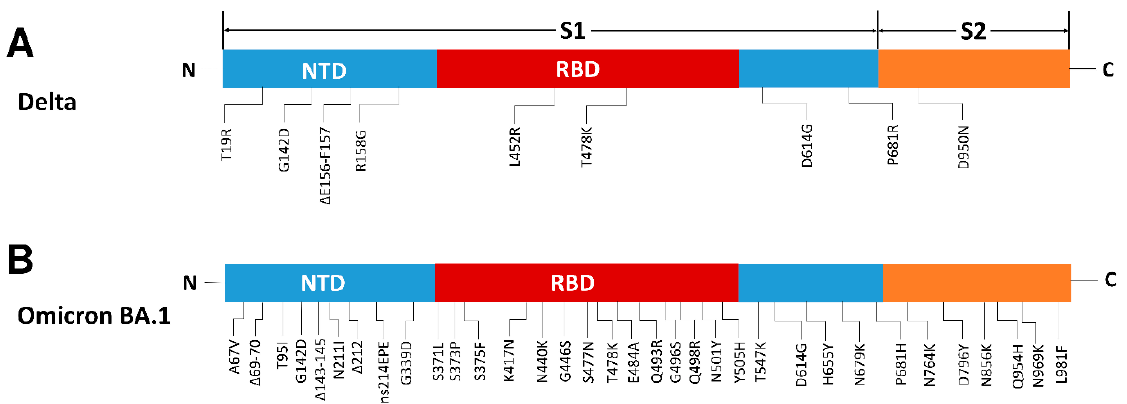
Figure 1. Schematic of severe acute respiratory syndrome coronavirus 2 (SARS-CoV-2) spike protein structure showing the mutations of the variants used in this study (https://outbreak.info (accessed on 10 August 2022)). The N-terminal domain (NTD) is shown in blue and red denotes the receptor- binding domain (RBD). ( A ) Linear mutation diagram of Delta spike (S1 and S2) proteins. ( B ) Linear mutation diagram of Omicron spike proteins. Mutations shared by Delta with Omicron are shown in red. Different mutations of Omicron and Delta at the same site are shown in blue.